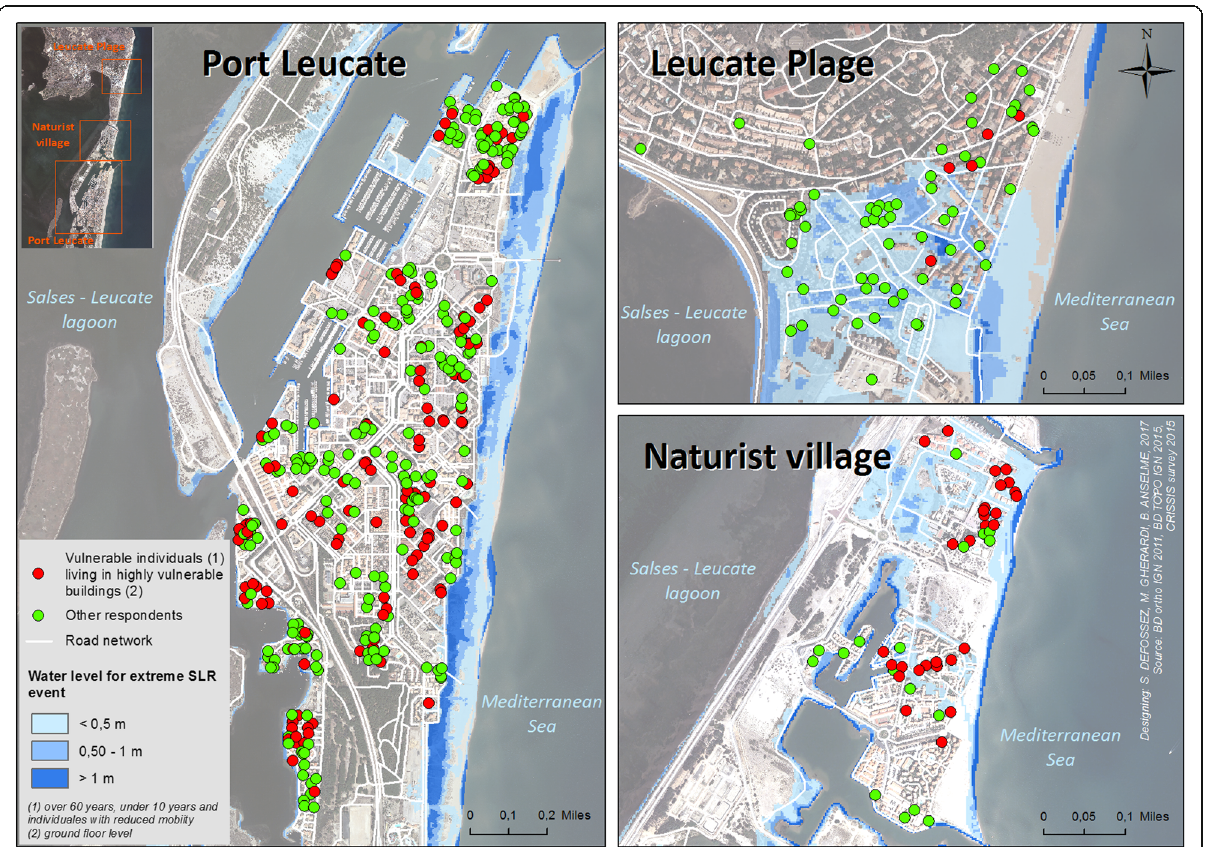
Fig. 5 Location of vulnerable populations based on age and health status (source: field